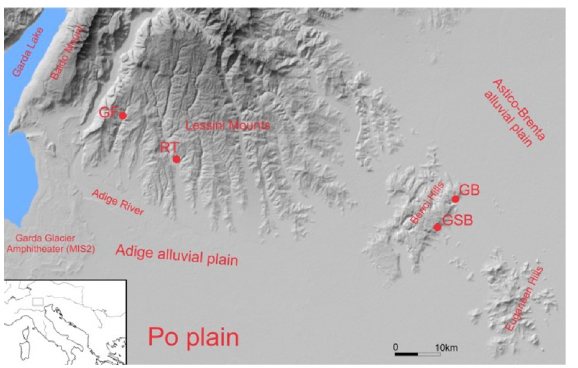
Fig 1. Location of Fumane Cave (GF) and other middle and upper paleolithic sites in NE Italy. (RT = Riparo Tagliente; GB = Grotta Broion; GSB = Grotta di San Bernardino). The map was produced with the CorelDRAW12 software, using digital terrestrial models (DTM) downloaded from http://www.regione.veneto.it/web/ambiente-e- territorio/geoportale and from http://www.territorio.provincia.tn.it/portal/server.pt/community/portale_ geocartografico_trentino. The figure is similar but not identical to the original image and is therefore for illustrative purposes only.